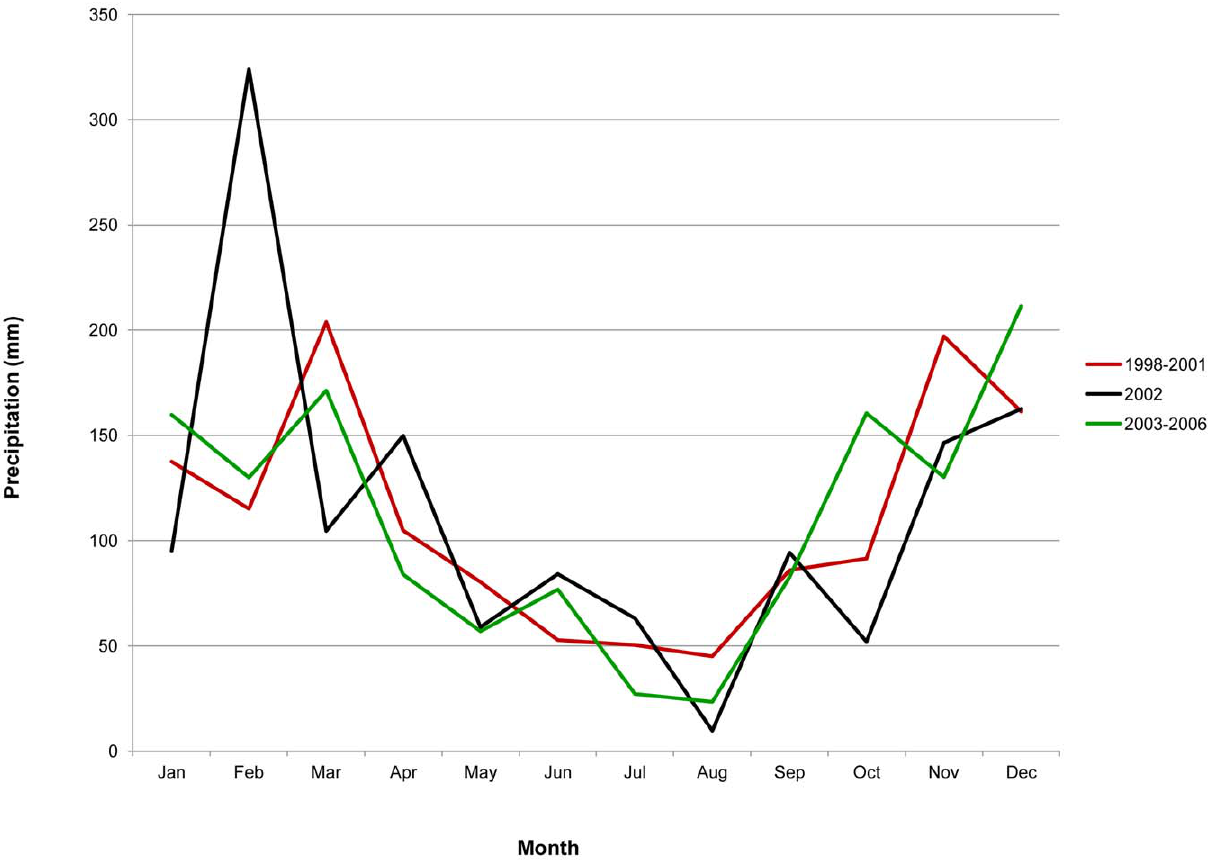
Figure 3. Average monthly precipitation in Santa Cruz de la Sierra, the capital of Santa Cruz Department, comparing the year of the reported hantavirus outbreak (2002) with averages of the preceding and following four years.